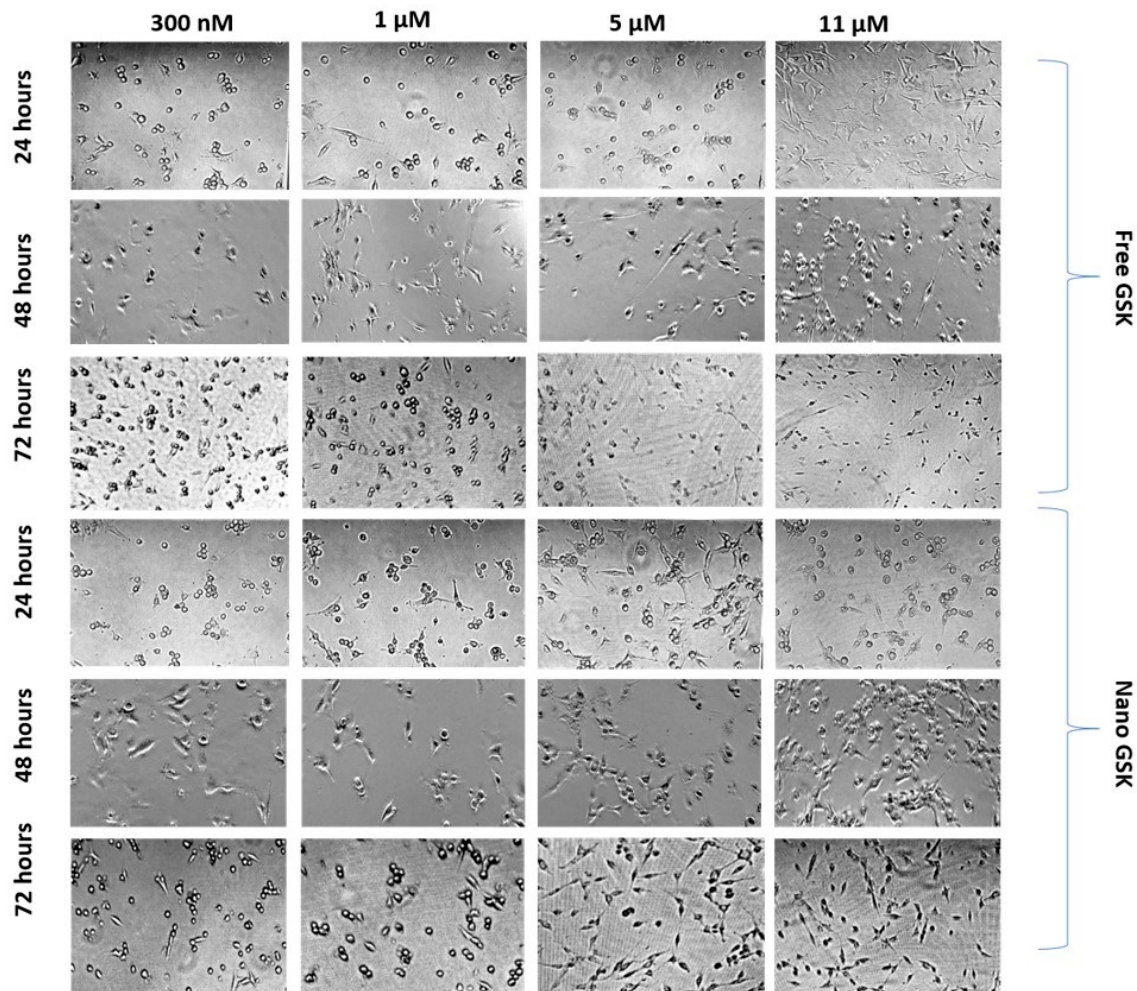
Figure 10. Morphological changes observed in U87-MG post treatment with free and nano GSK at 24, 48 and 72 h. The first three rows represent free GSK treatment and the bottom three indicate morphology of U87-MG cells post treatment with nano